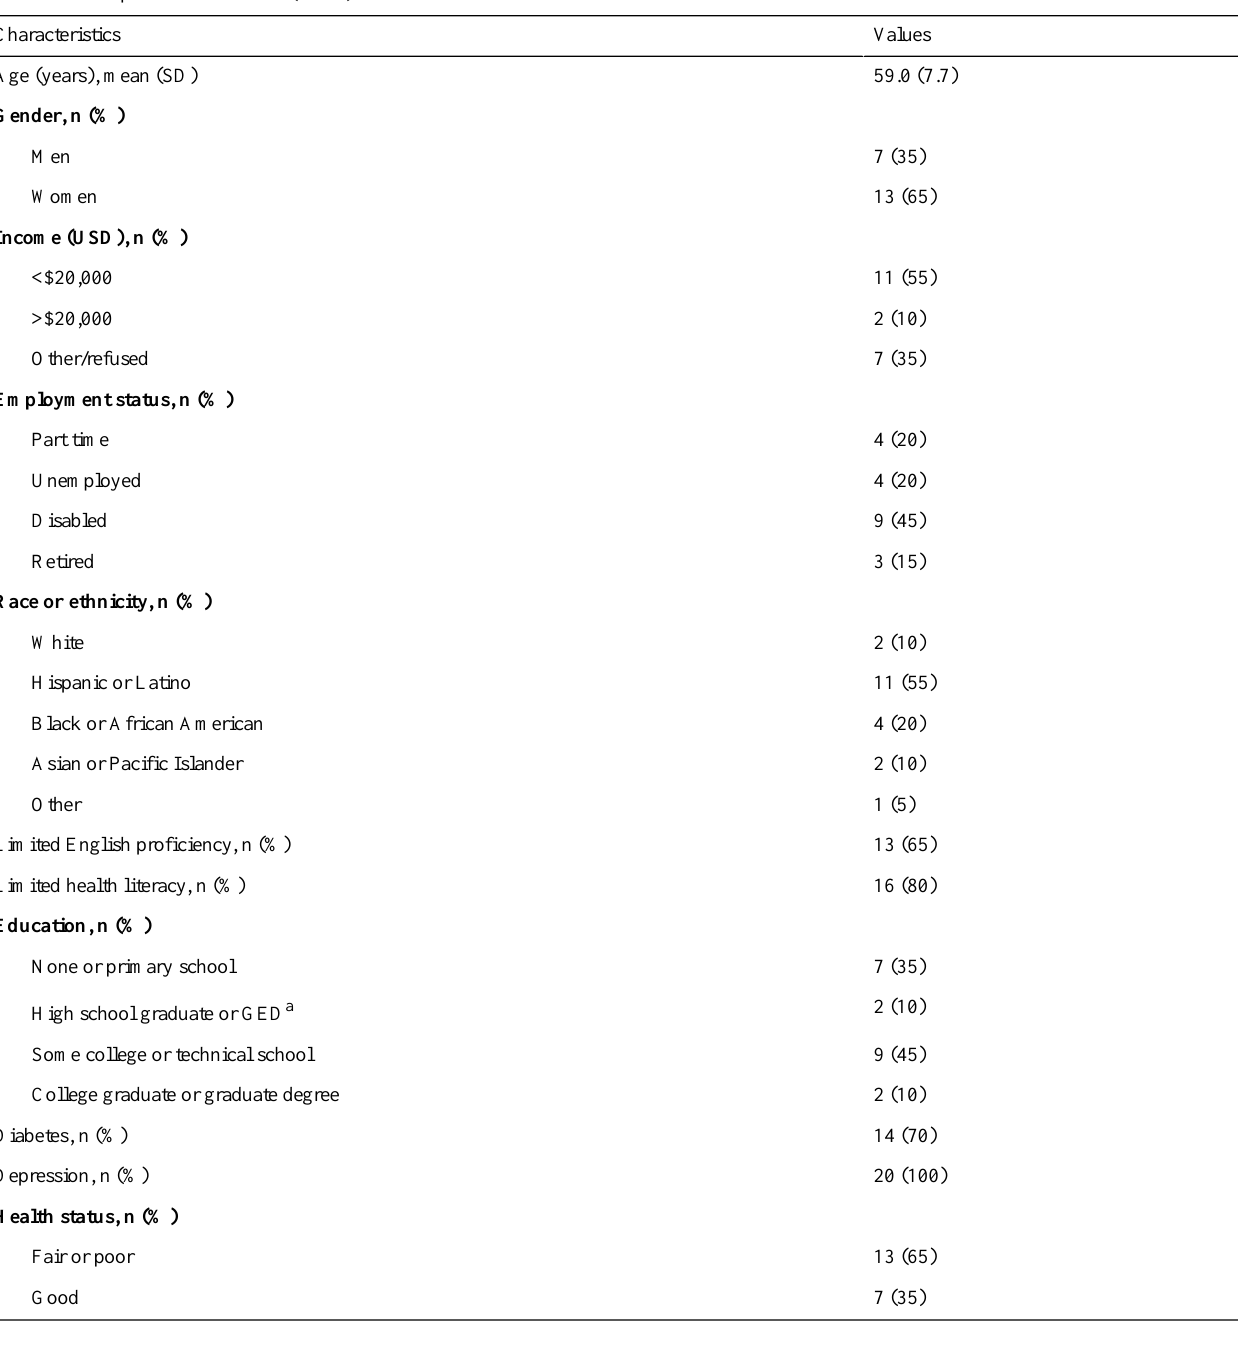
Table 1. Participant characteristics (N=20).